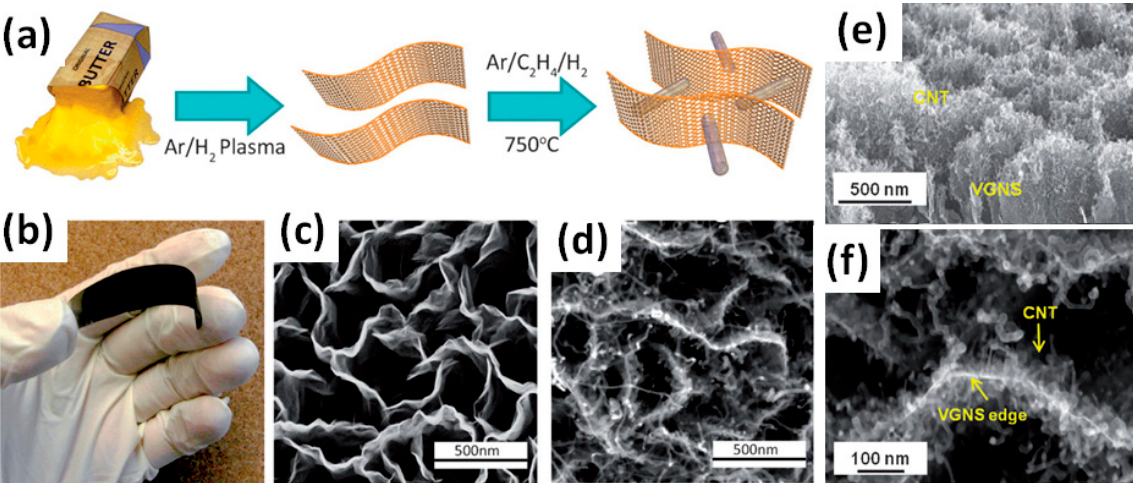
Figure 16. Schematic for the direct growth of CNT onto vertical graphene nanosheets (VGNS) ( a ). Photograph of the as-grown VGNS/CNTs on a flexible graphite substrate ( b ). SEM micrograph of pristine VGNS prior to CNT growth ( c ). SEM micrograph of the final hybrid VGNS/CNTs nanoarchitecture in which the graphene nanosheets were decorated with a high density of CNT ( d ). Cross-sectional ( e ) and high-resolution ( f ) SEM images of the VGNS/CNT (Reproduced with permission of [44]. Copyright Wiley, 2014).